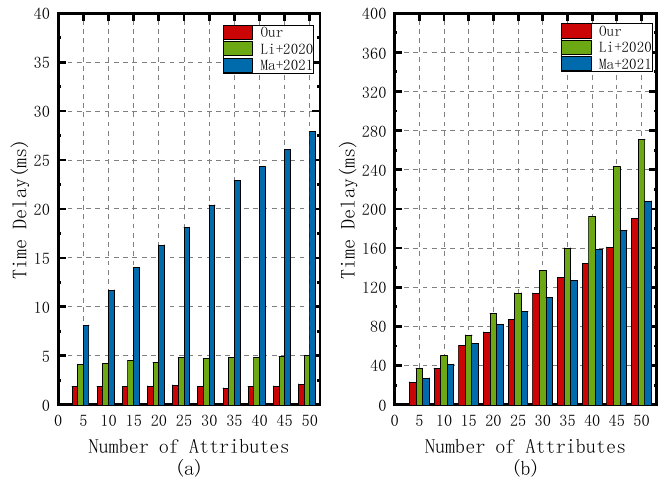
Figure 6. ( a ) Cost of user encryption. ( b ) Cost of RSU encryption [23,24].